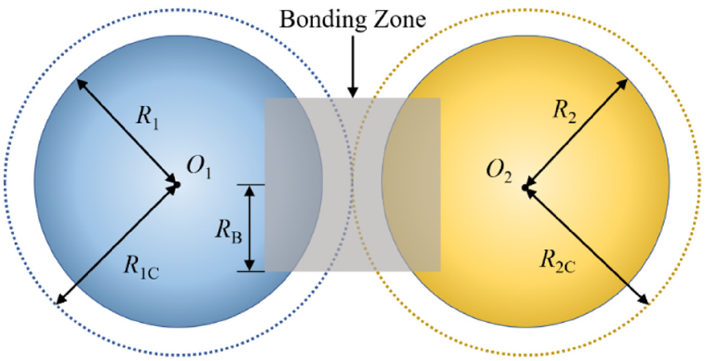
Figure 10. Hertz–Mindlin with Bonding contact model, where R 1 and R 2 are the practical radii of particles, mm; R 1 C and R 2 C are the contact radii between particles, mm; R B is the bonding zone radius between particles, mm.